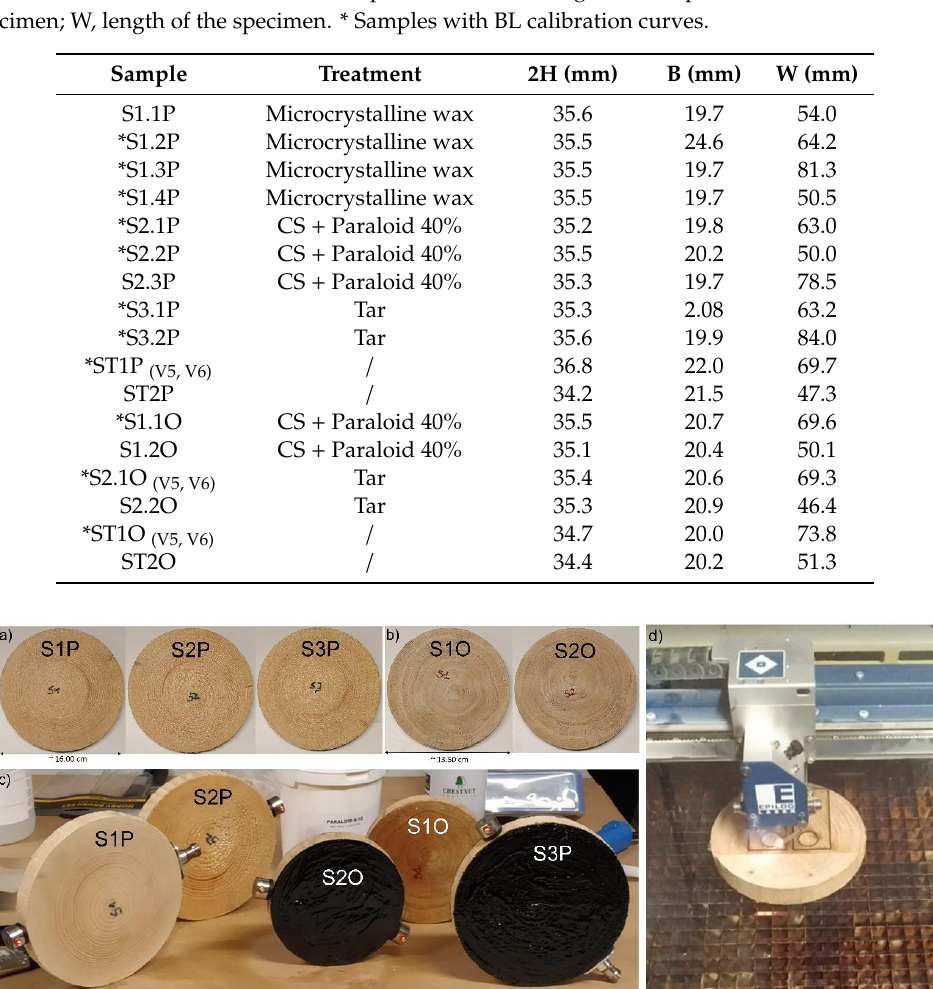
Figure 1. Wood slices acclimatized in climate chamber. ( a ) Pine slices; ( b ) Oak slices; ( c ) Pine and oak slices coated with chemicals; ( d ) Specimen creation method. Names as reported in Table 1. During the tensile tests, the samples were hooked by means of specially created grippers to the universal testing machine UTM (MTS company, Eden Prairie, MN 55344 USA, see Figure 2a,d–f) for the load transmission (load cell of 5 kN). During the tensile tests, a very slow crosshead displacement rate of 1.5 mm/min was used. This low value of displacement was selected as it provided the best emission statistic capability limiting the strong oscillations in the force, as well as in the AE signals, during the initial phase of the decay before the mechanical inertia [21].